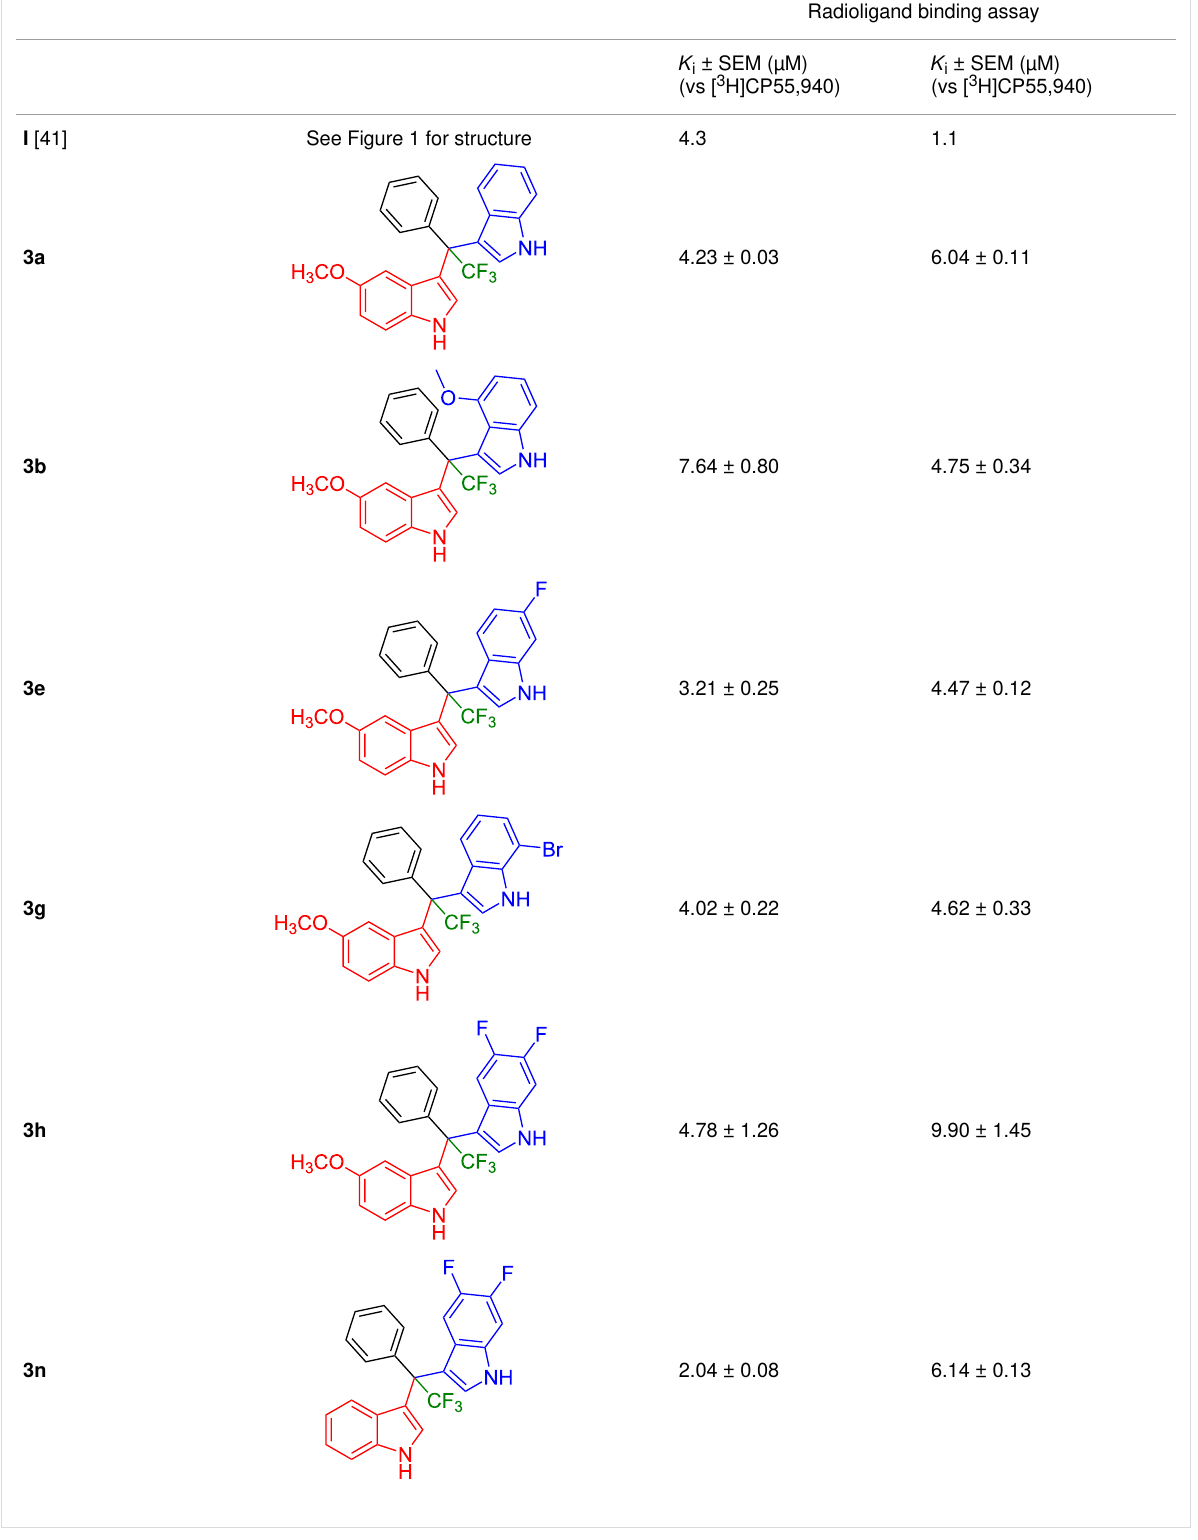
Table 5: Binding affinities of unsymmetrical fluoromethyl-substituted DIM derivatives for cannabinoid receptors.